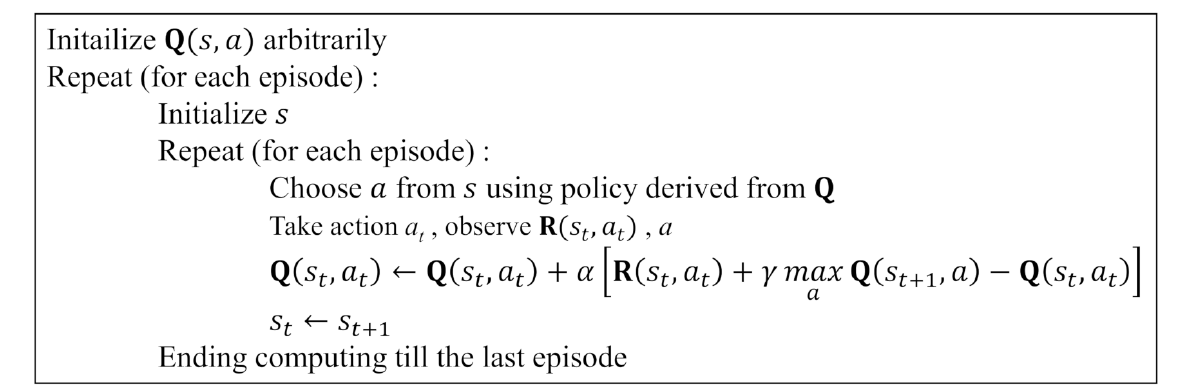
Figure 6. Q-learning